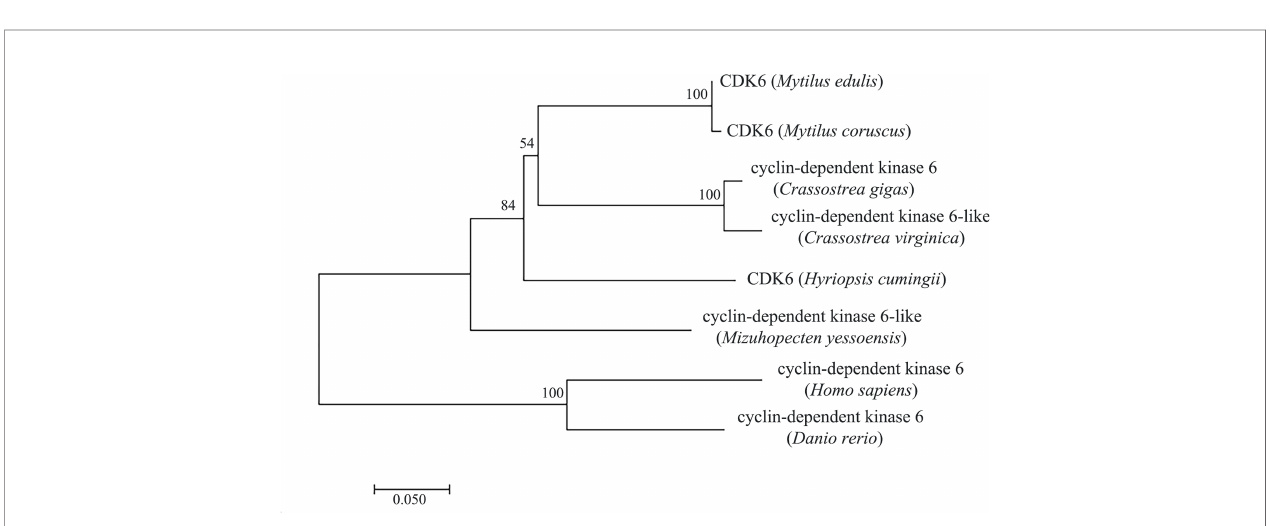
FIGURE 3 | NJ tree of the Hc-CDK6 amino acid sequence with CDK6 sequences from other species. GenBank accession numbers are as in Figure 2 , the number on the node indicates the con fi dence value of the test for 1000 Bootstrap